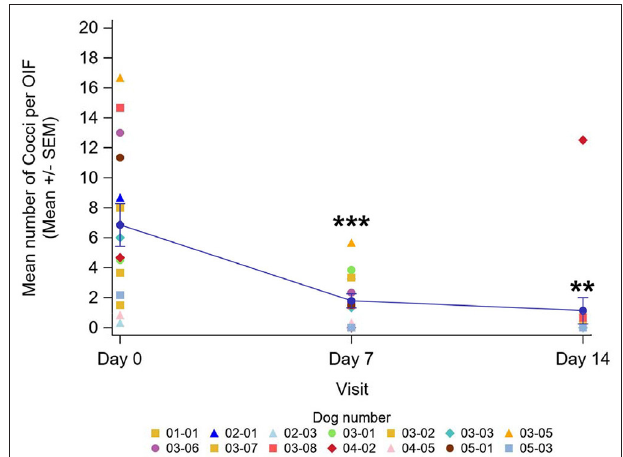
FIGURE 1 | Evolution of the mean number of cocci per OIF at each visit with individual data by dog ( n = 14)—Line plot. **Results are significantly different from D0 ( P < 0.01). ***Results are significantly different from D0 ( P < 0.001).